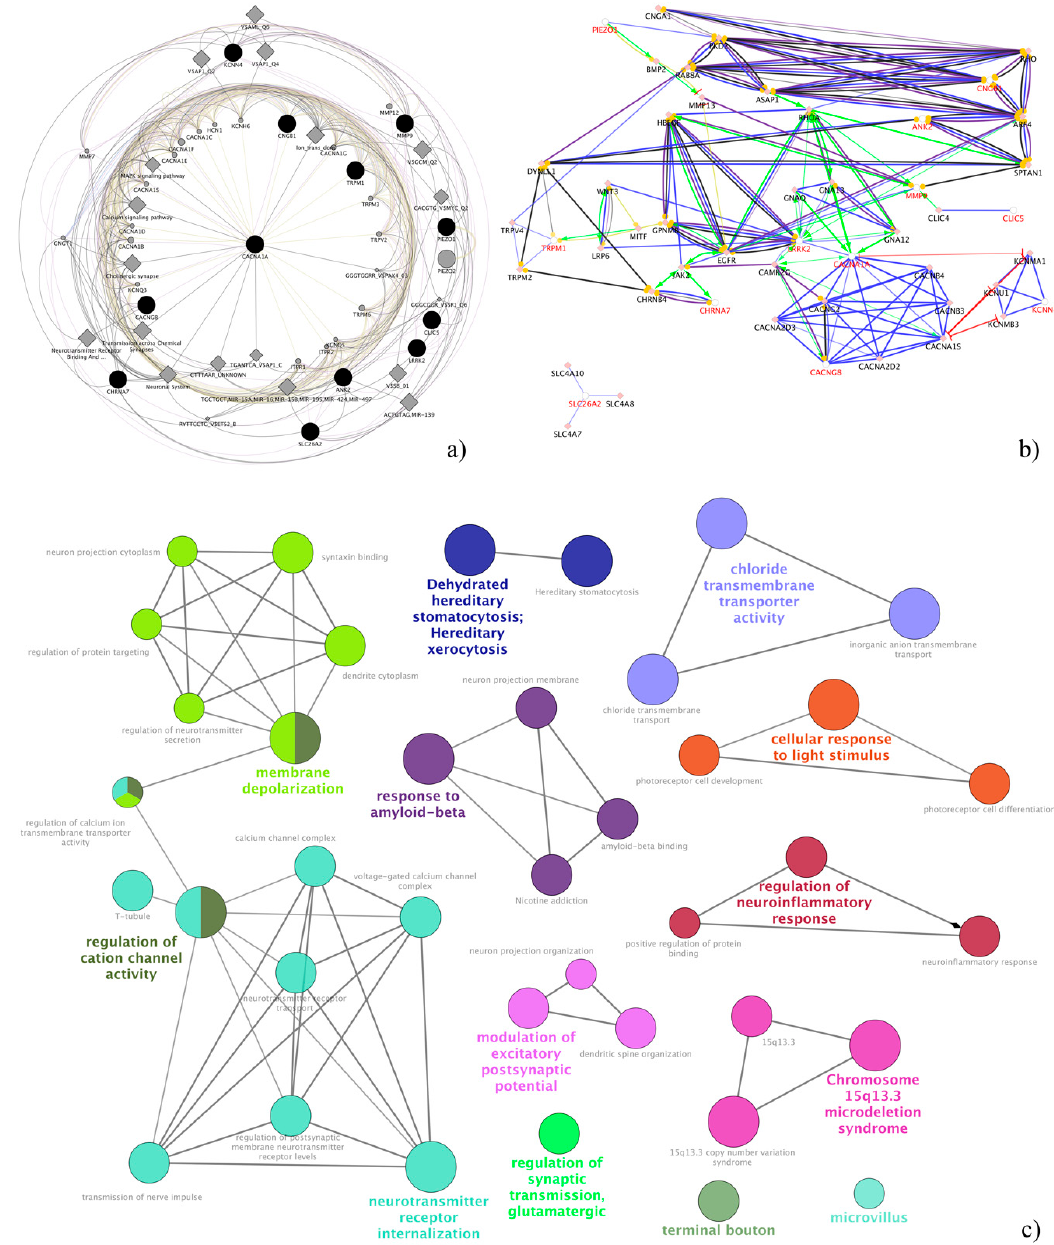
Figure 2. Pathway analysis by Cytoscape and its plugins. The spherical graph ( a ) represents the connections between analyzed ion channel-related genes computed by GeneMANIA, while ( b ) and ( c ) show pathways/sub-pathways and interactions computed by ClueGO and CluePedia plug-ins, respectively. It is clear that regulation of neurotransmission represented the most relevant macropathway.